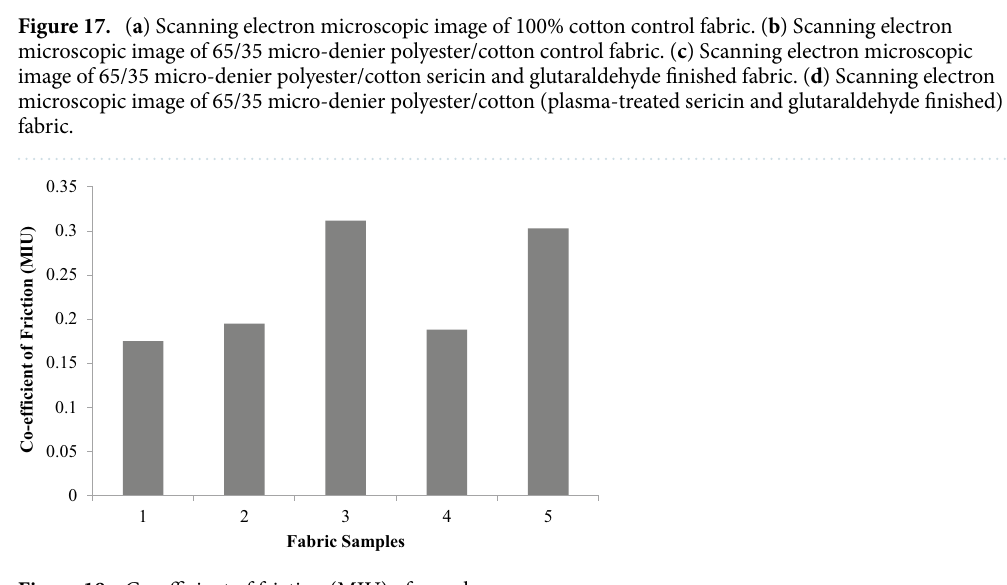
Figure 18. Co-efficient of friction (MIU) of